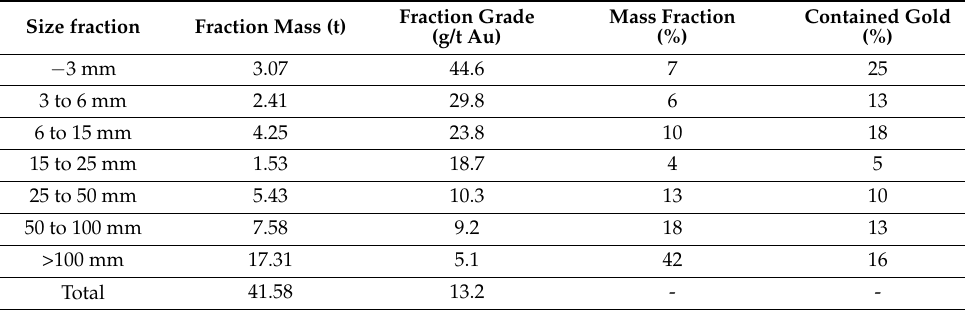
Table 6. Granulometric analysis of a bulk sample of blasted